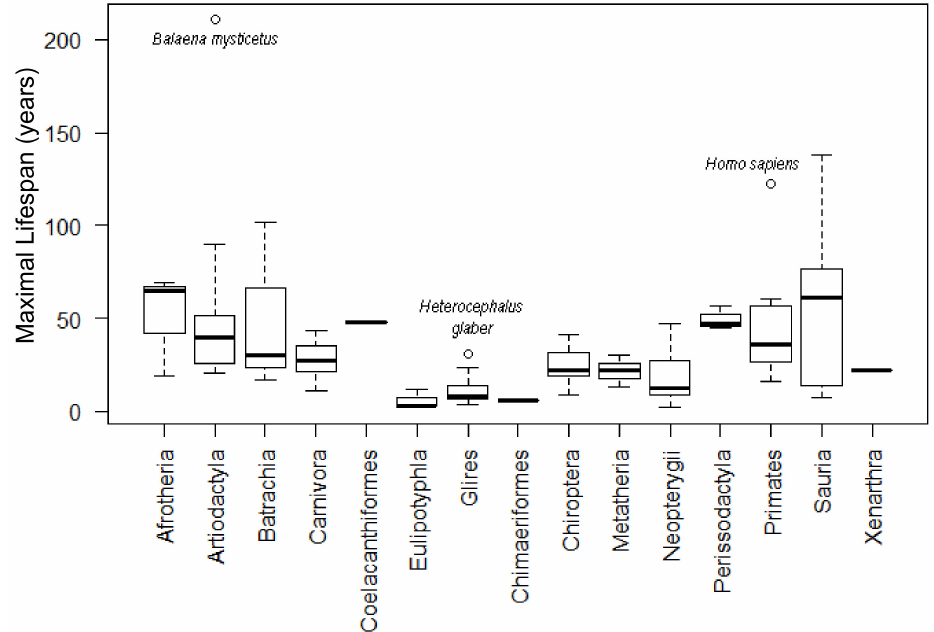
Figure 6. Representation of lifespans for all tested phylogenetic groups. The organisms with the longest lifespan in the Neopterygii dataset were the carp ( Cyprinus carpio (47 years)), followed by the goldfish ( Carassius auratus (41 years)). The Siamese fighting fish ( Betta splendens) had the shortest lifespan in the group (2 years). The correlation analyses show that fifteen amino acid residues in the p53 core domain were significantly associated with a prolonged lifespan (Figure 7A). We found that the most common variation in the long-lived Neopterygii was the presence of a serine (S) at positions corresponding to 98, 128, and 211 of human p53, and the presence of valine (V) at positions 128, 150, 217, and 232. On the other hand, in the short-lived organisms in Neoropterygii, we identified threonine (T) at positions 98, 100, 141, 217, and 260; glutamic acid (E) at positions 110, 128, 150, and 291; and serine at positions 141, 203, and 235. We reasoned that the abundance of glutamic acid could result in the decreased affinity of p53 to DNA due to the local change in the ionic charge at the site of the amino acid p53 variant. Indeed, the PROVEAN tool predicted a deleterious effect on p53 function for glutamic acid at position 128. In addition, according to the PHANTM classifier, C141S substitution led to a decrease in p53 transcription activity by 41.08% as compared to